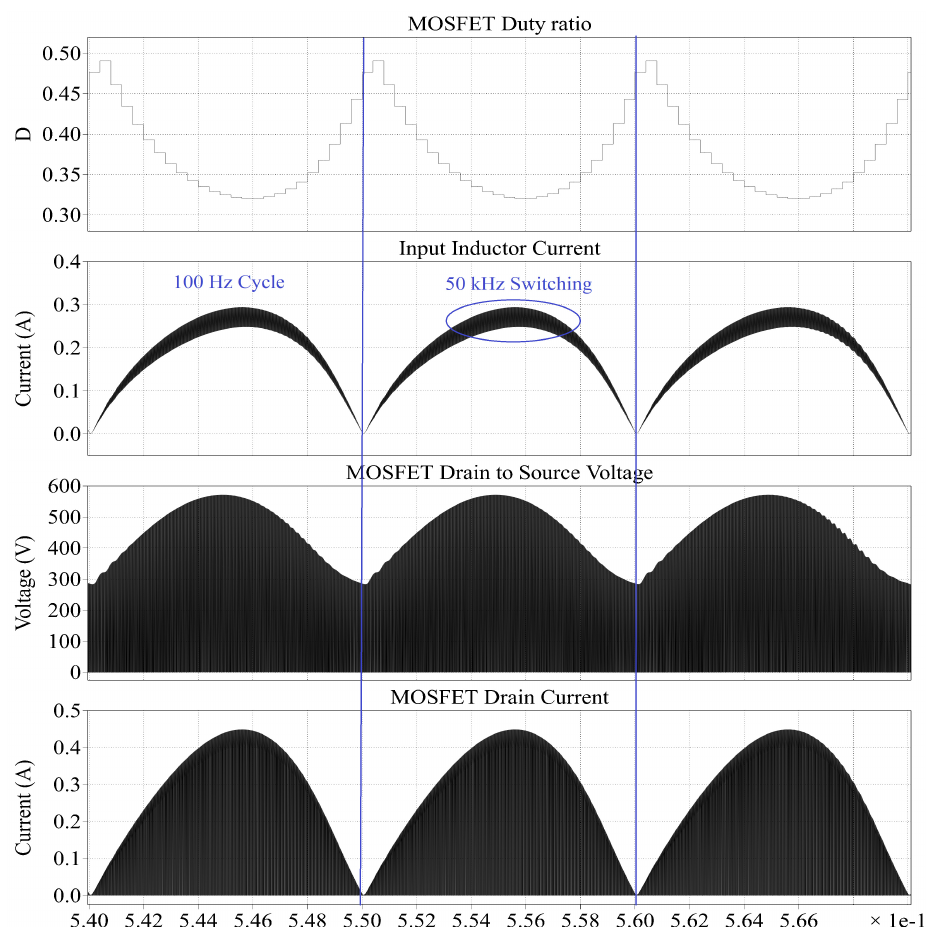
Figure 9. Waveforms in the input side of the DC-DC converter. MOSFET duty ratio D , input inductor current i dc , MOSFET drain to source voltage V ds , and MOSFET drain current i d